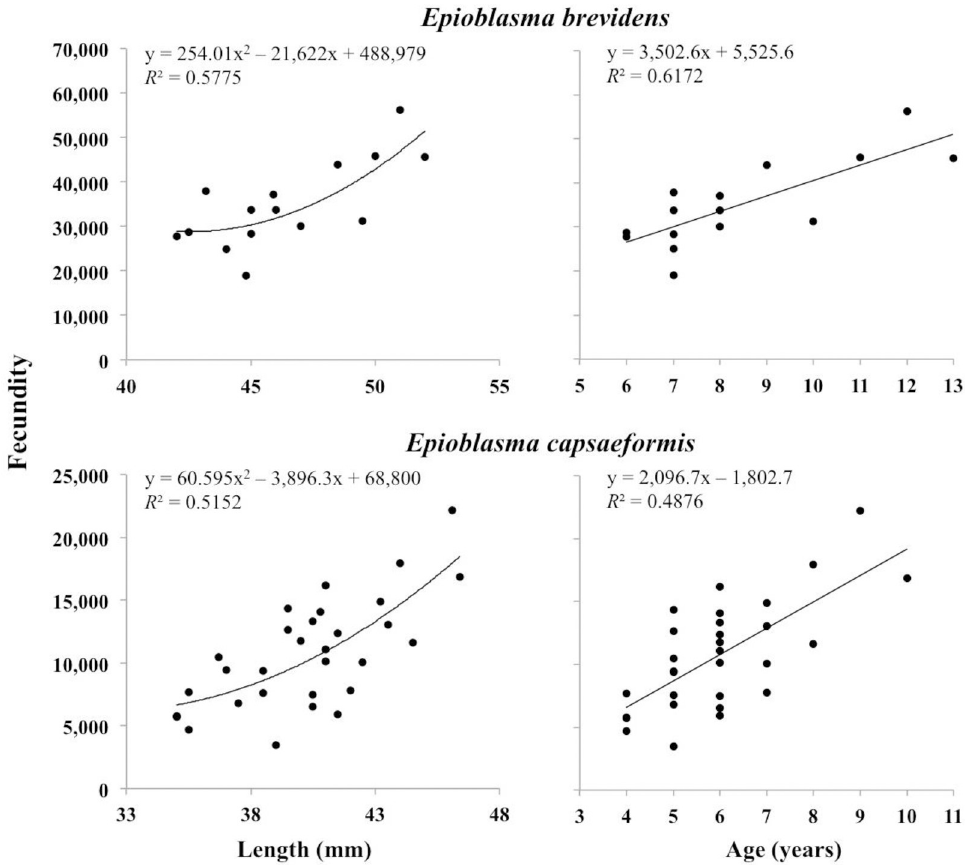
Fig 9. Length–and age–fecundity relationships observed for Epioblasma brevidens (length: p = 0.0057; age: p = 0.0006) and E . capsaeformis (length: p < 0.0001; age: p < 0.0001) sampled at Kyles Ford in the Clinch River, Hancock County, TN, in 2013. Ages were estimated based on shell length using von Bertalanffy growth curve equations presented in (4). Data for E . capsaeformis includes 10 additional samples collected from various sites in the Clinch River, Hancock County, TN, in 2002